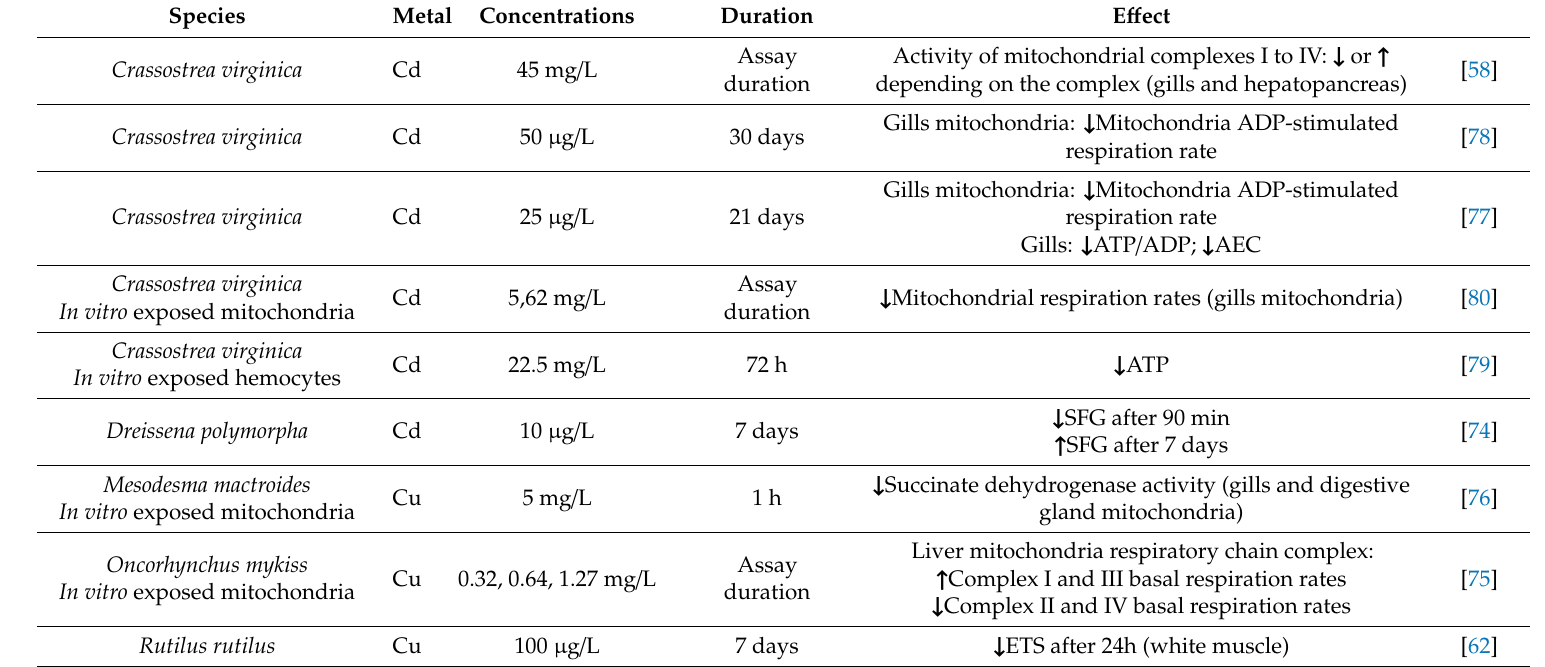
Table 5. Summary of studies describing toxic metal impacts on free cellular energy and mitochondrial